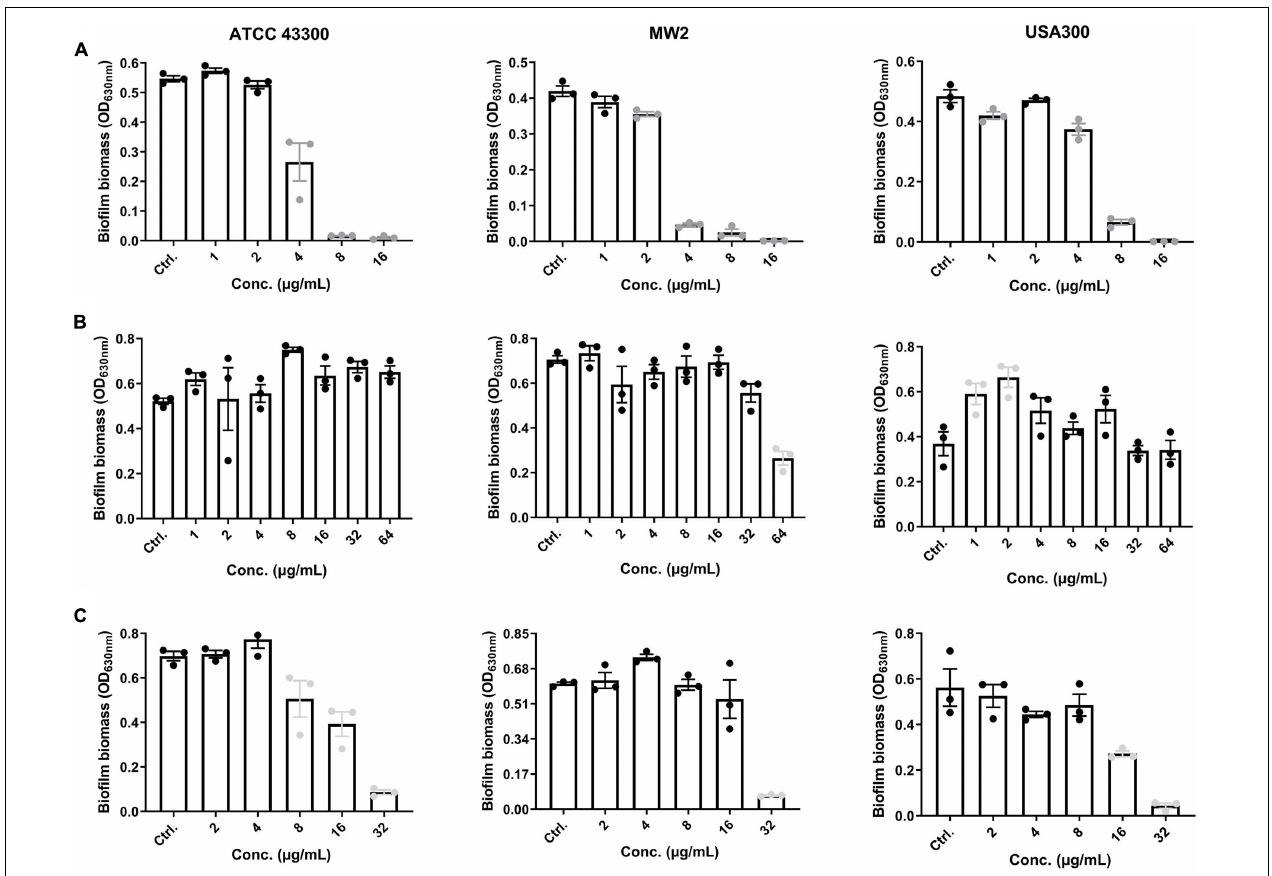
FIGURE 2 | Effective anti-biofilm activity of EP against S. aureus . (A) Inhibition of biofilm formation by S. aureus in the presence of varying concentrations of EP. (B) Limited biofilm eradication effects of VAN even at high concentrations. (C) Eradication of 24-h mature biofilms in the presence of the indicated concentrations of EP. Mature biofilms were formed in 96-well cell culture plates with TSB-g. All experiments were performed in triplicate. Results are represented as mean ± standard deviation. Gray dots indicate p <